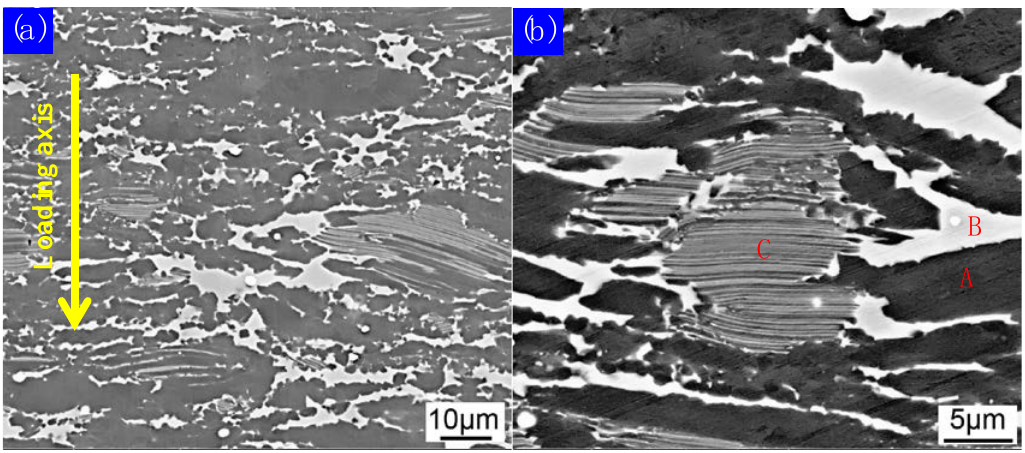
Figure 1. The microstructure of as-forged Ti-45Al-5.4V-3.6Nb-Y alloy in backscattered electrons (BSE) mode: ( a ) low magnification; ( b ) high magnification. Table 1. EDS analysis of Figure 1.